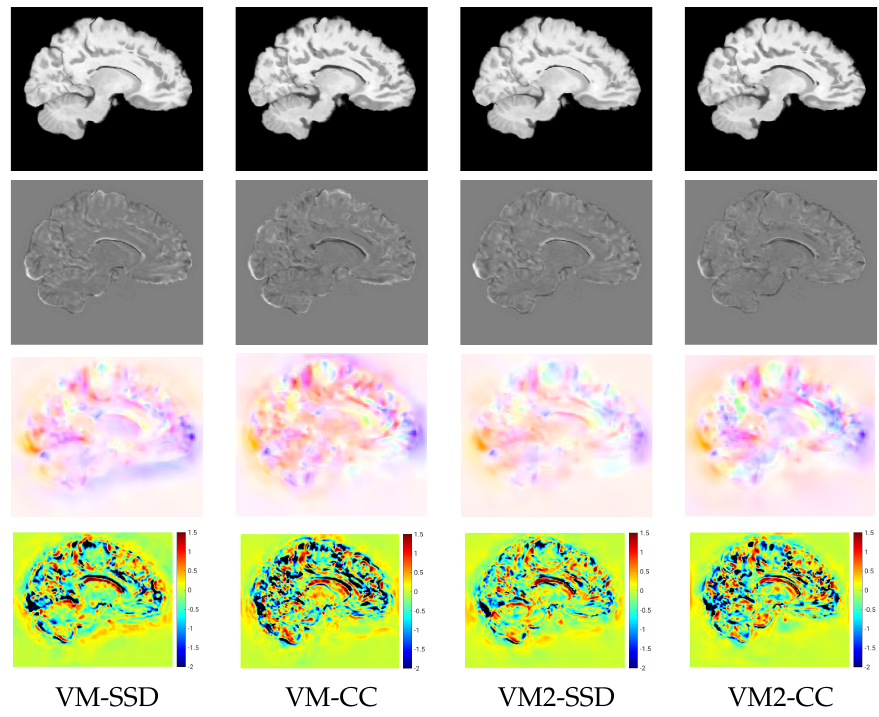
Figure 6. NIREP16. VoxelMorph experiments. Sagittal view of the warped sources, the intensity differences after registration, the displacement fields, and the logarithm of the Jacobian determinants after registration for the different image similarity metrics. For the negative Jacobian values, the logarithm has been replaced by -2 and displayed in black.